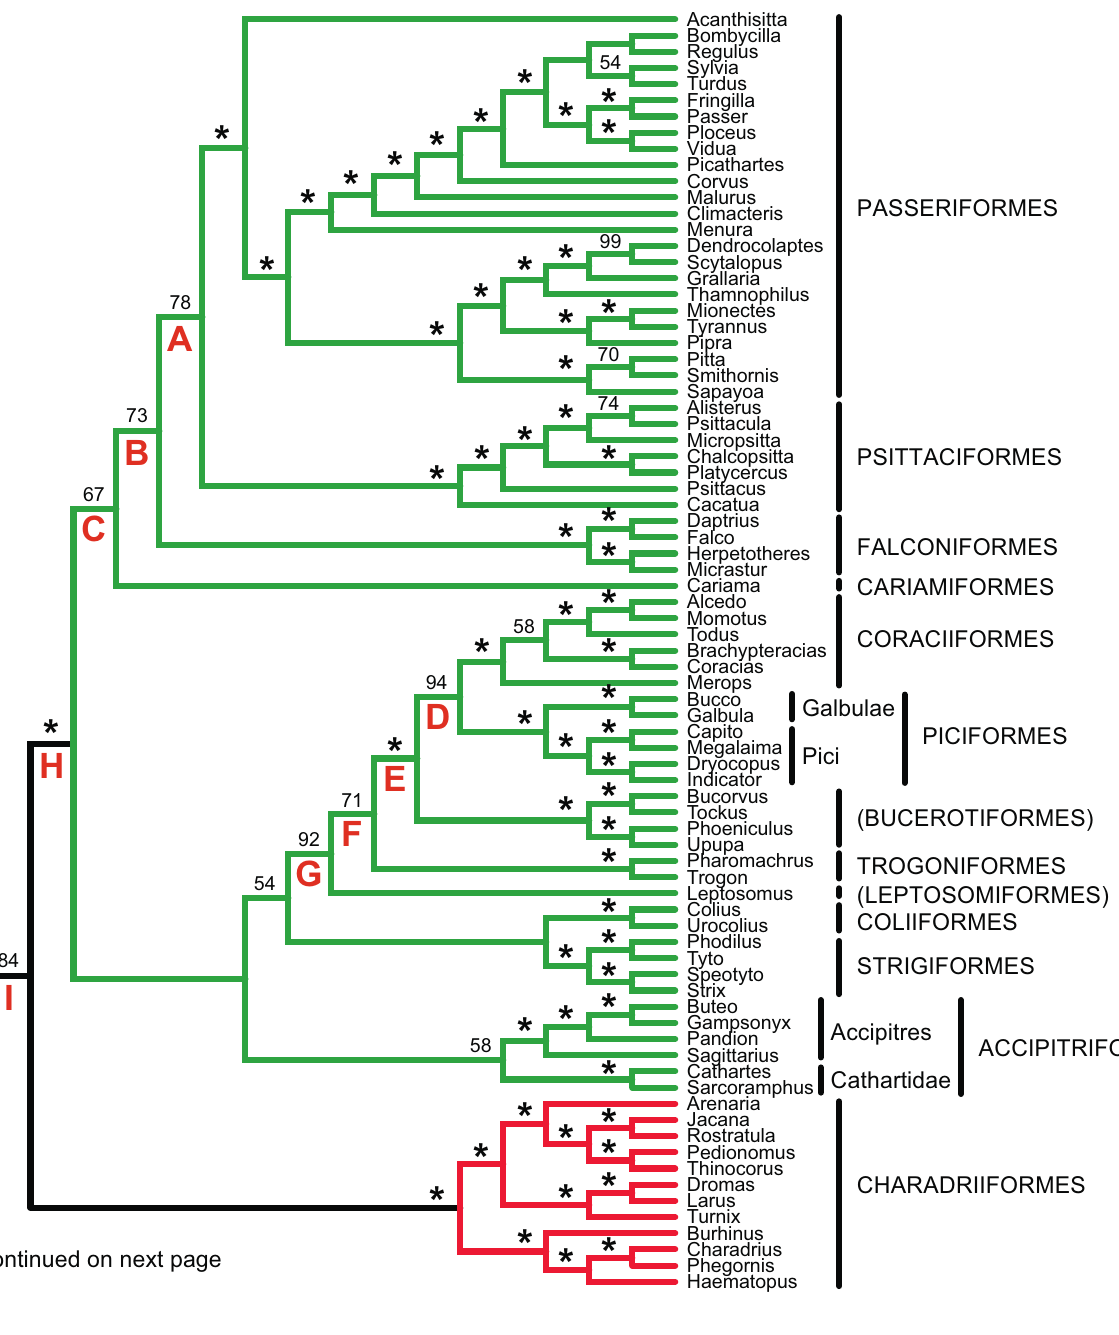
Figure 1. Estimate of avian phylogeny based upon nucleotide sequence data (maximum likelihood [ML] tree using the (cid:42)(cid:55)(cid:53)(cid:14)(cid:44)(cid:14)(cid:299)(cid:3) (cid:80)(cid:82)(cid:71)(cid:72)(cid:79)(cid:12)(cid:3) (cid:68)(cid:81)(cid:71)(cid:3) (cid:87)(cid:75)(cid:72)(cid:3) (cid:75)(cid:76) gher-level classification described in the text. Nodes with 100% support are indicated with an asterisk. Red asterisks indicate nodes with 100% support that define supra-ordinal clades with extensive independent corroboration (see below). Coloring conventions here will be used in all trees, and named supra-ordinal clades are indicated using letters below branches (see Table 1 for